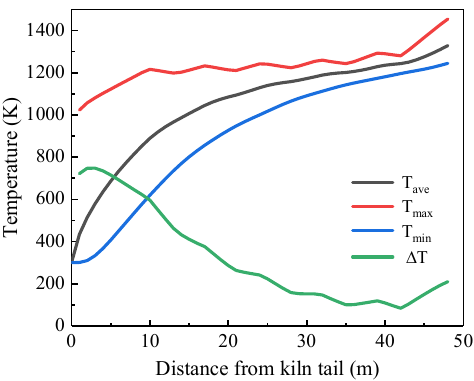
Figure 7. Temperature distribution of the cross-section along the axis of the rotary kiln.